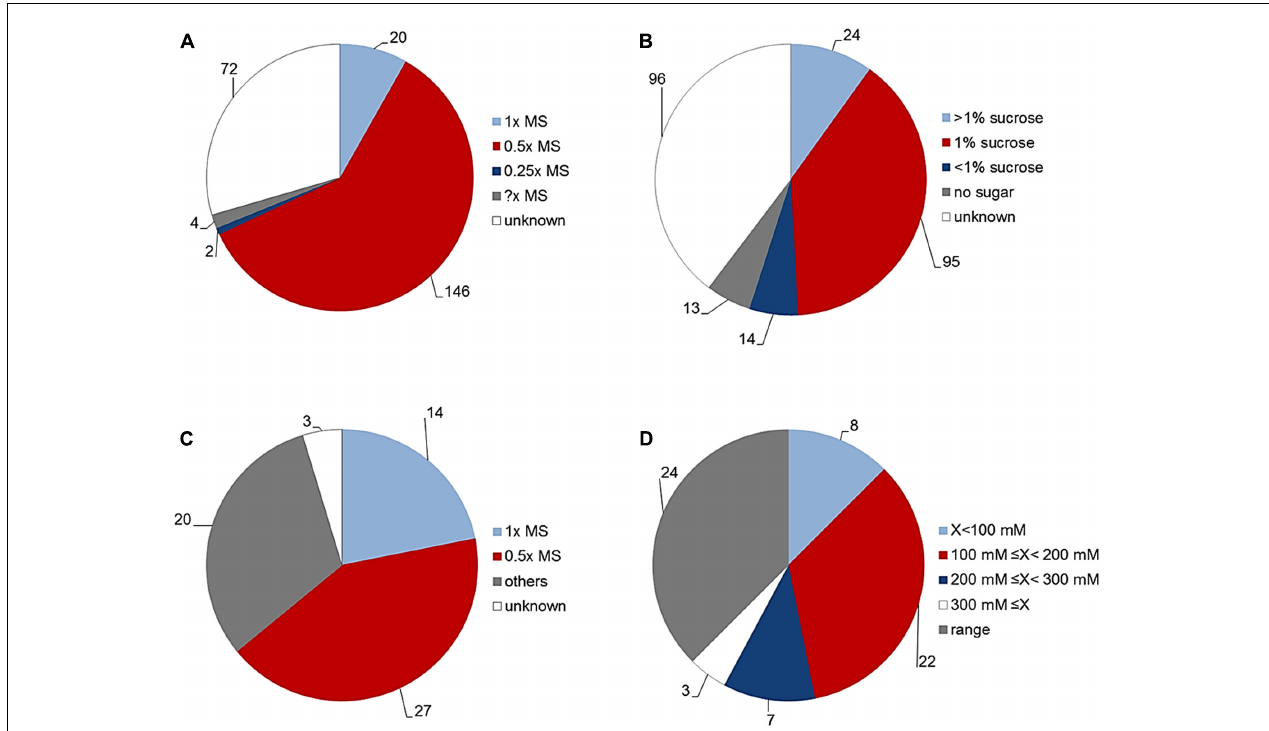
FIGURE 7 | “Normal” in vitro growth conditions for Arabidopsis plants. (A) Culture medium used for Arabidopsis grown in vitro according to articles ( n = 242) published in the five highest impact Plant Science journals (Web of Science) during 2016. MS = Murashige and Skoog basal salt mixture. (B) Concentration of sucrose added to the culture medium for Arabidopsis grown in vitro in the same publications. (C) Culture conditions used for salt-stress studies of Arabidopsis according to articles ( n = 64) published in the five highest impact Plant Science journals (Web of Science) from 2012 to 2016. (D) Concentration of salt published in the same articles for stress studies of Arabidopsis .